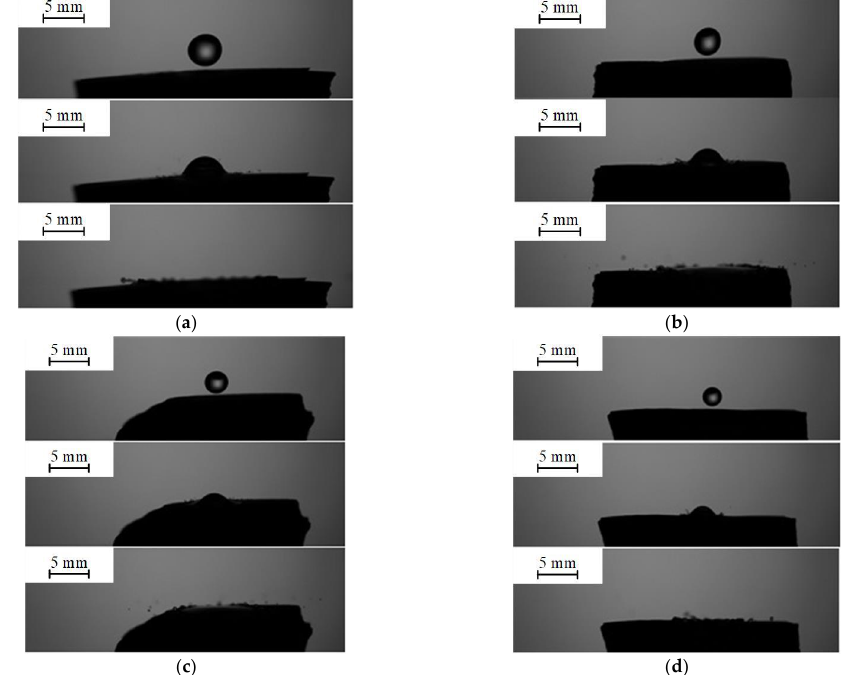
Figure 13. Images of collisions of distilled water droplets with substrates in the form of monolithic anthracite fragments at varying droplet sizes, U d = 2.6 m/s: ( a ) — droplet R d = 2 mm; ( b ) — droplet R d = 1.6 mm; ( c ) — droplet R d = 1.3 mm; ( d ) — droplet R d = 1.1 mm. anthracite fragments at varying droplet sizes, U d = 2.6 m/s: ( a )—droplet R d = 2 mm; ( b )—droplet R d = 1.6 mm; ( c )—droplet R d = 1.3 mm; ( d )—droplet R d = 1.1